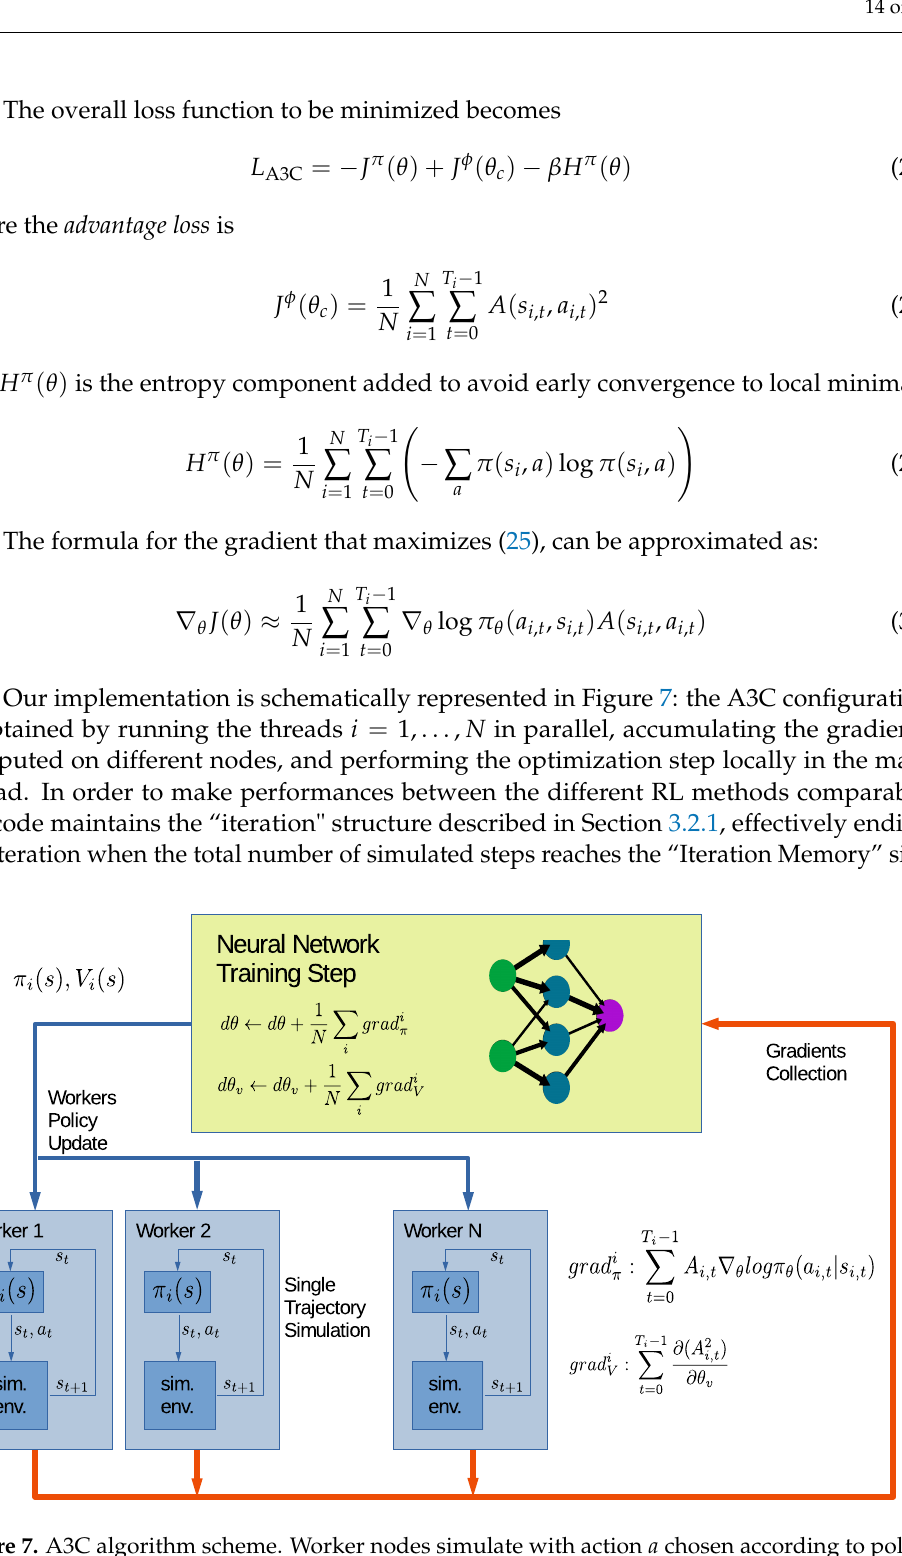
Figure 7. A3C algorithm scheme. Worker nodes simulate with action a chosen according to policy π k ( s ) . Gradients are accumulated until a transitions threshold is reached, then NN weights are updated via backpropagation, and policy π k + 1 is